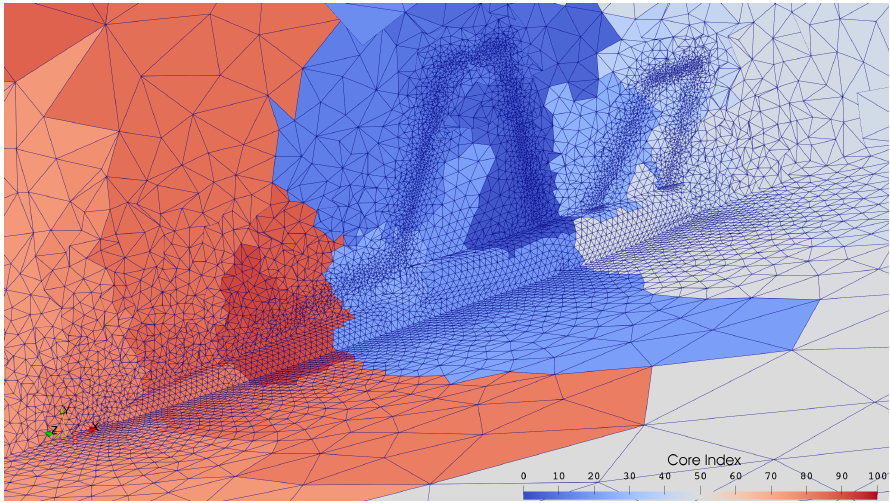
Figure 28. A 100-part partitioning of the mesh used for solving problems in Section 3.2.